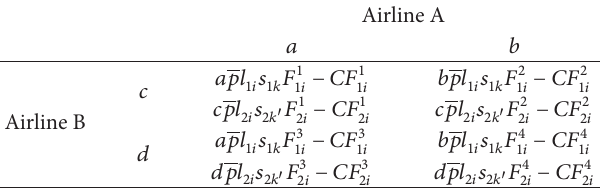
Table 1: Payoff matrix of two airlines in